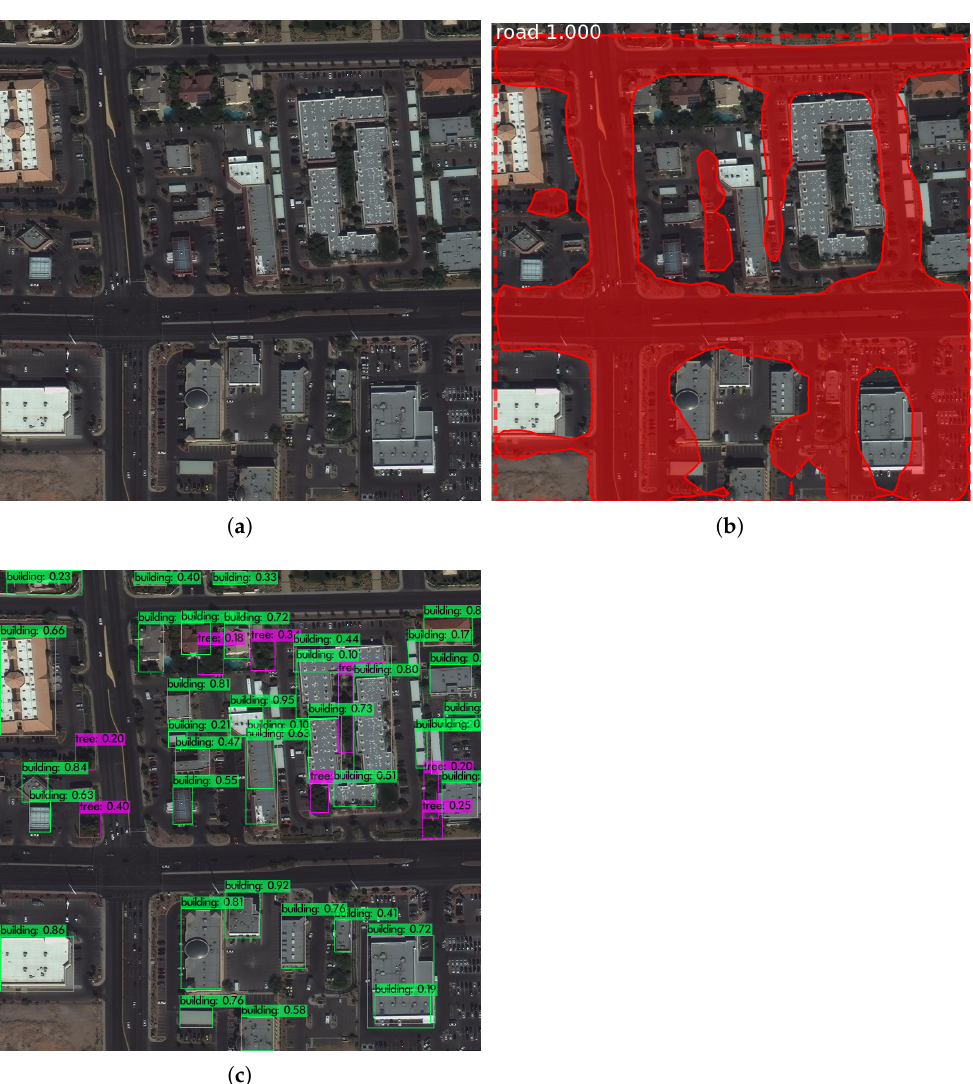
Figure 14. The entire image-to-simulation process: ( a ) Unaltered satellite image of urban intersection in Las Vegas, Nevada; ( b ) Las Vegas satellite image decorated with road mask; and ( c ) Las Vegas satellite image decorated with YOLO v4